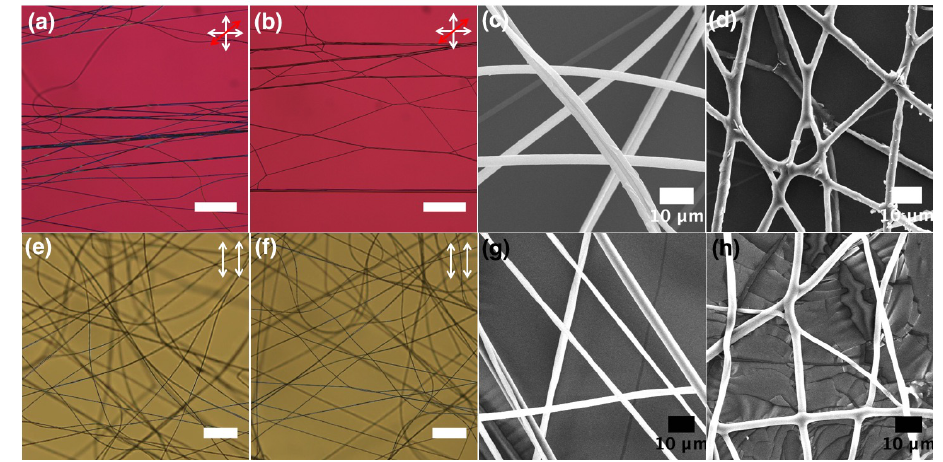
Figure 4. POM and corresponding SEM image of: ( a , c ) LCE-PVP fibers at 20 ◦ C; ( b , d ) LCE-PVP fibers in isotropic phase at 72.5 ◦ C; ( e , g ) pure PVP fibers at 20 ◦ C and; ( d , h ), after heating to 75 ◦ C. Images ( a , c ) are with red wave plate between crossed polarizers (scale bars: 200 µ m.) The white double-ended arrows depict the orientation of polarizer and analyzer, respectively, and the red double-headed arrow in ( a , b ) shows the direction of optic axis of a first-order λ plate inserted in the light